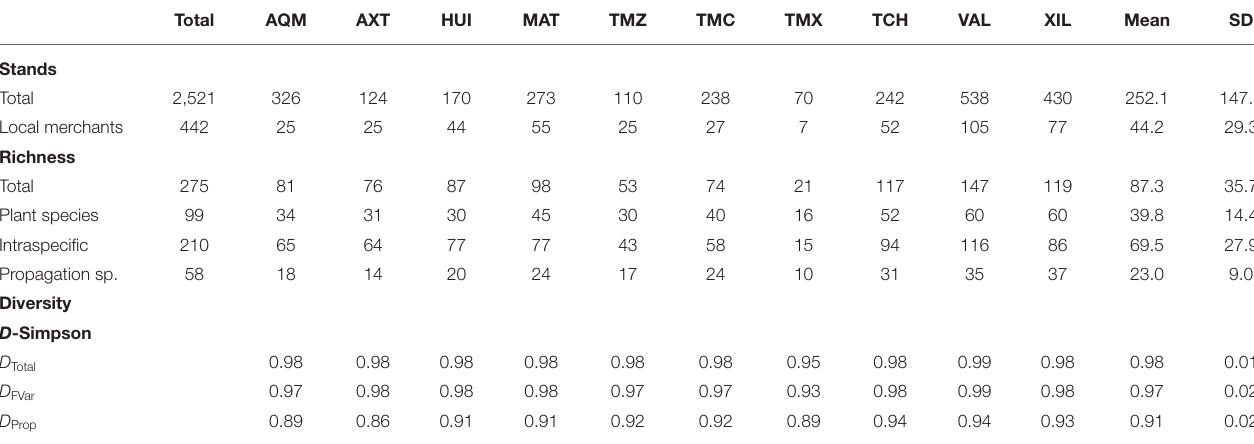
TABLE 2 | Inter- and intra-specific richness and diversity of local food plant diversity in 10 rural markets of the Huasteca Potosina.